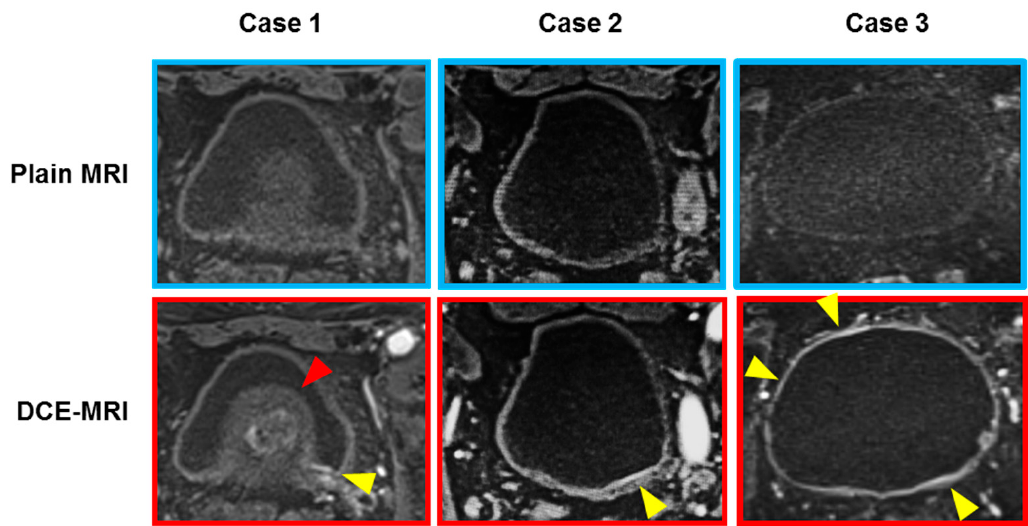
Figure 1. Three representative cases with flat lesions suspected bladder carcinoma in situ (CIS). Heterogeneous and blurry contrast-enhancement of the bladder mucosa and the submucosa (lamina propria) at the arterial phase of DCE-MRI is considered as a case of bladder CIS (yellow arrowheads). Case 1: A 71-year-old man with T4 high-grade urothelial carcinoma with CIS. DCE-MRI shows submucosal enhancement around the left ureteral orifice, which was pathologically proven CIS. The suspected CIS lesion (yellow arrowhead) was difficult to look at with the cystoscopy because of the enlarged benign prostate (red arrowhead). Case 2: An 88-year-old man with an isolated CIS on the posterior wall. Case 3: A 70-year-old woman with broad-range CIS in the whole bladder wall.